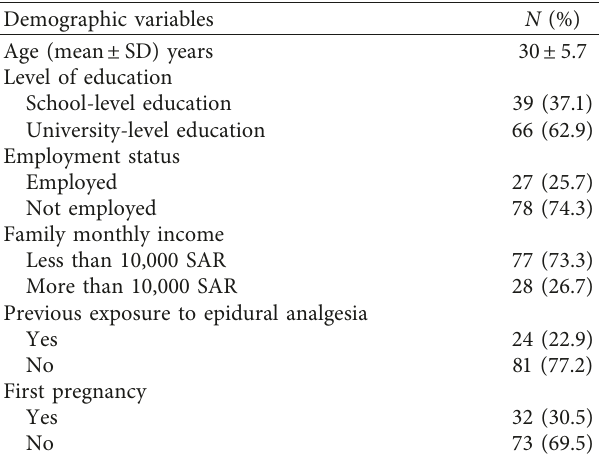
Table 1: Demographic